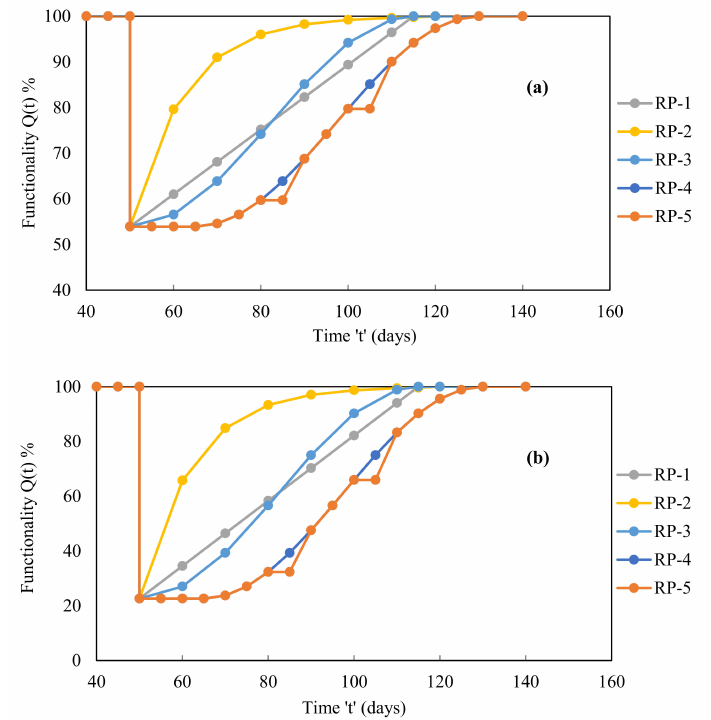
Figure 18. Functionality curves for unsymmetrical building Case II (R = 4) using various recovery paths ( a ) with respect to DBE level and ( b ) with respect to MCE level.